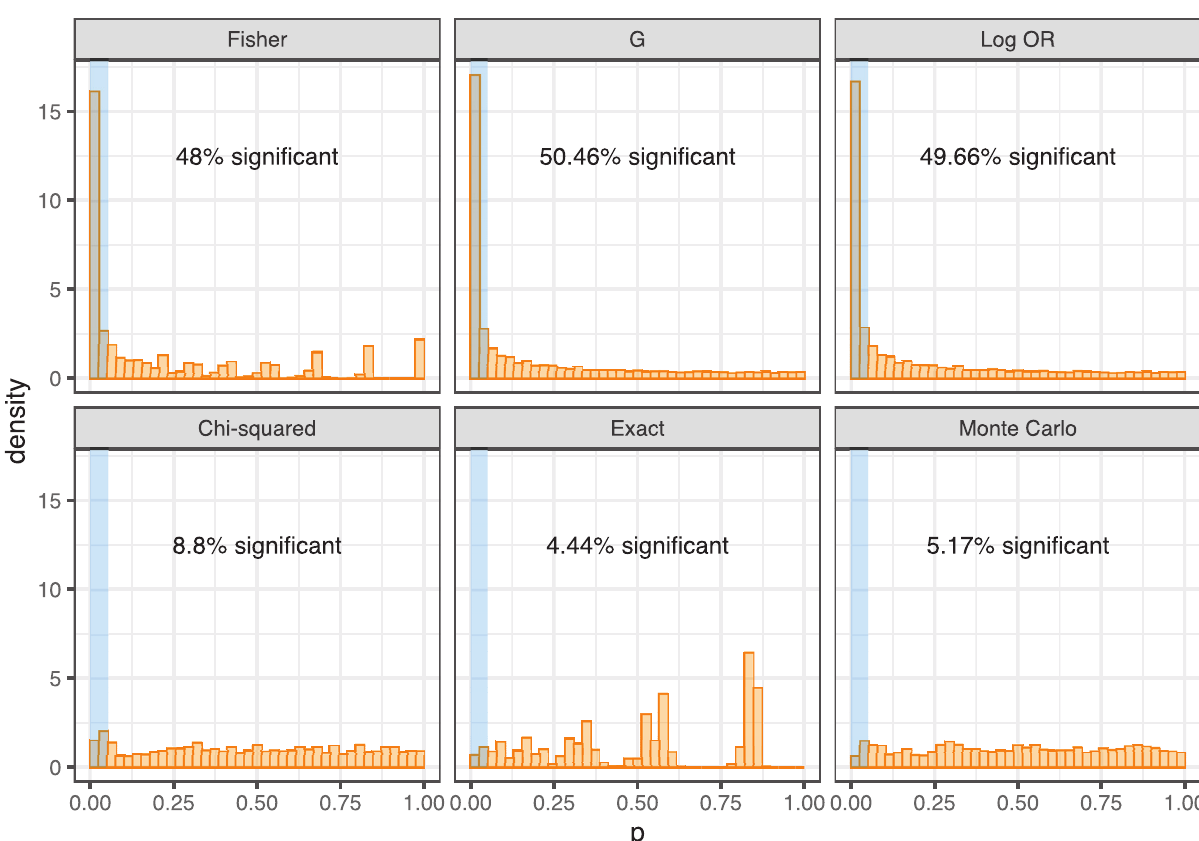
Fig 6. Comparison to standard exclusivity tests. Standard independence tests (top row: Fisher’s exact test, G-test and log odds ratio (OR) test, from left to right) are heavily miscalibrated for data generated from placing mutations on lineage trees under the null. GeneAccord’s gene pair placement test (bottom row: chi-squared approximation, exact test and with Monte Carlo smoothing, from left to right), apart from some enrichment with the chi- squared approximation, shows proper calibration.